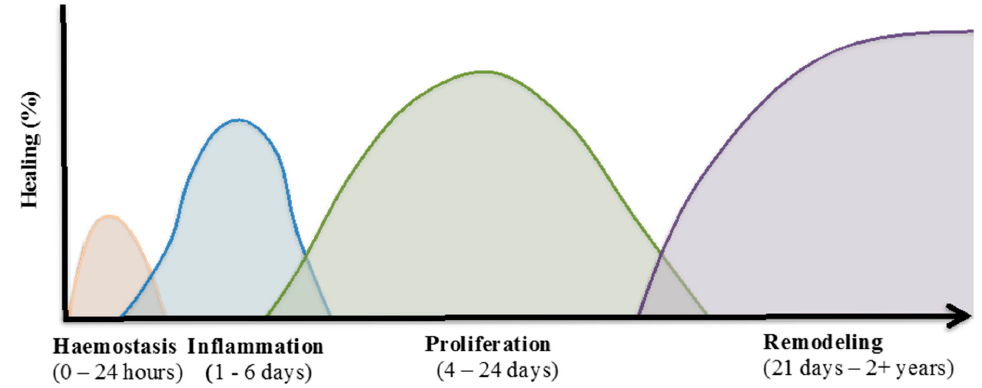
Figure 1. Wound healing process. The normal tissue repair process is comprised of continuous and overlapping phases. These four phases include: (i) Haemostasis; (ii) inflammation; (iii) proliferation; and (iv) remodelling. Each phase consists of different cellular events which requires the interplay of multiple cell populations [22]. multiple cell populations